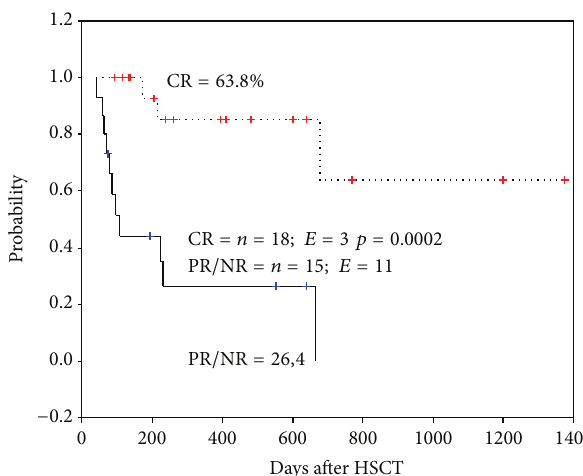
Figure 1: Two-year Kaplan-Meier estimate of overall survival according to response to mesenchymal stromal cell treatment. CR: complete response, PR/NR: partial or nonresponse, 𝑛 : number, and 𝐸 :